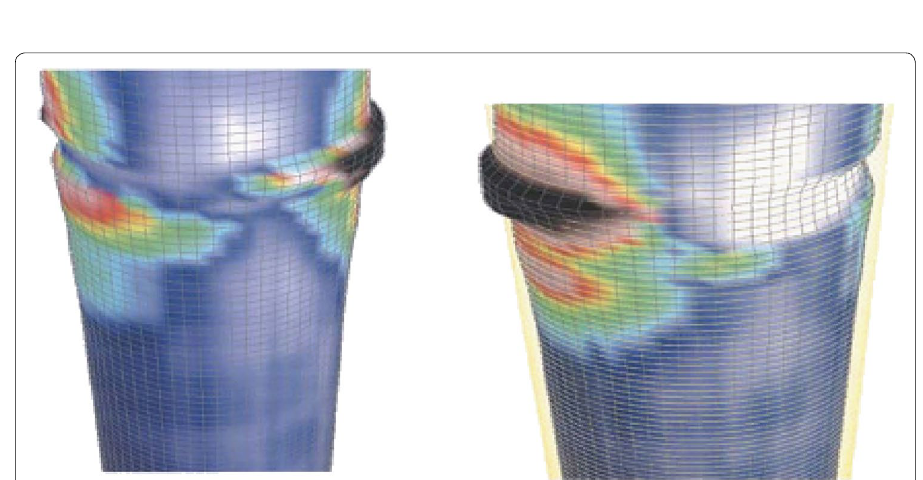
Fig. 6 Casing damage at a depth of 59 m—image from the MIT-60 probe from 2003 (Bujakowski et al.